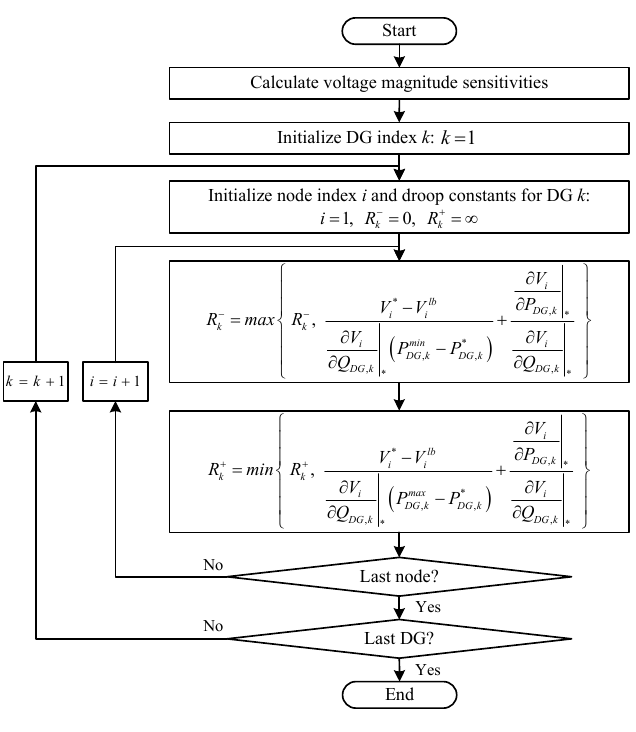
Figure 5. Flow chart of the initial estimation.